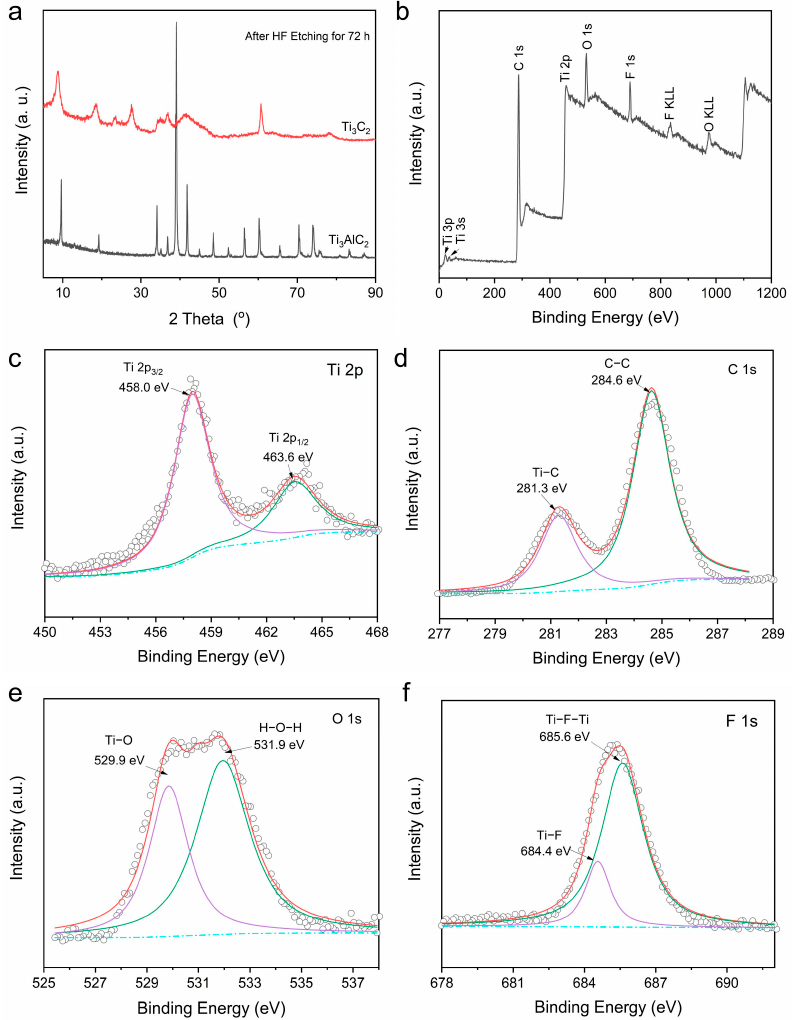
Figure 3. ( a ) XRD patterns of the MAX phased Ti 3 AlC 2 before and after being etched in HF solution; XPS spectra of Ti 3 C 2 : ( b ) survey; ( c ) Ti 2p; ( d ) C 1s; ( e ) O 1s; ( f ) F 1s.